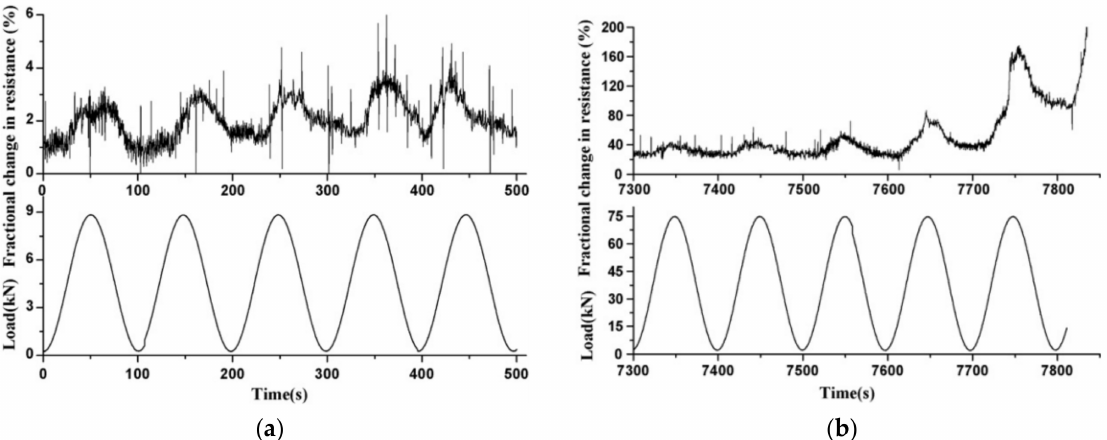
Figure 21. The fractional variation in electrical resistance versus time during repeated flexural loading: ( a ) at first 5 cycles; ( b ) at last 5 cycles. Reproduced with permission from [72], Elsevier,